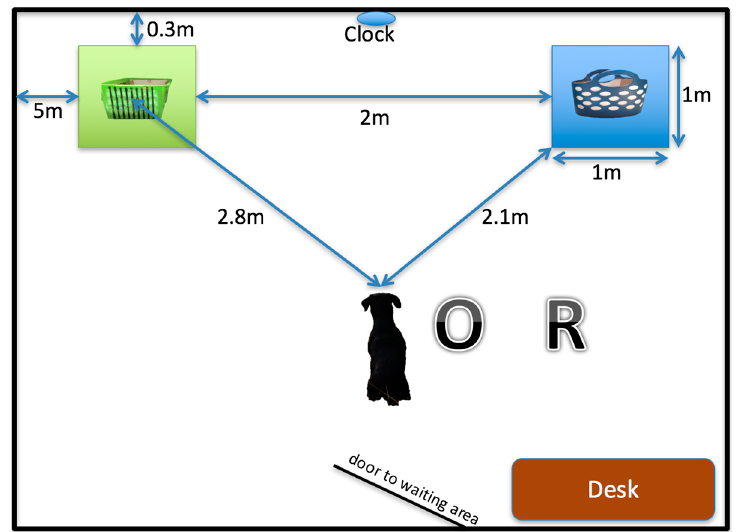
Figure 1. Setup and dimensions of the testing area including the walking distance. O: designated area of the owner, R: designated area of the researcher.